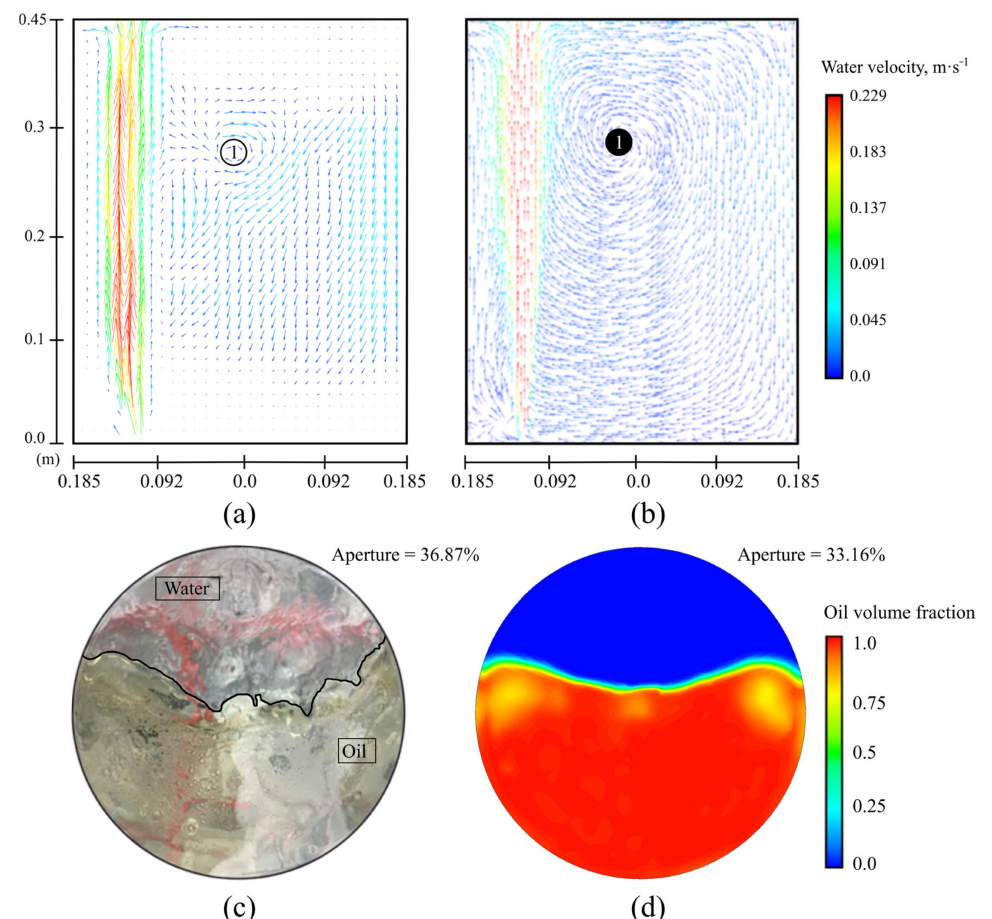
Figure 4. Mathematical validation of ( a ) PIV velocity fields, ( b ) numerical velocity fields, ( c ) experimental opening eye, and ( d ) numerical opening eye.